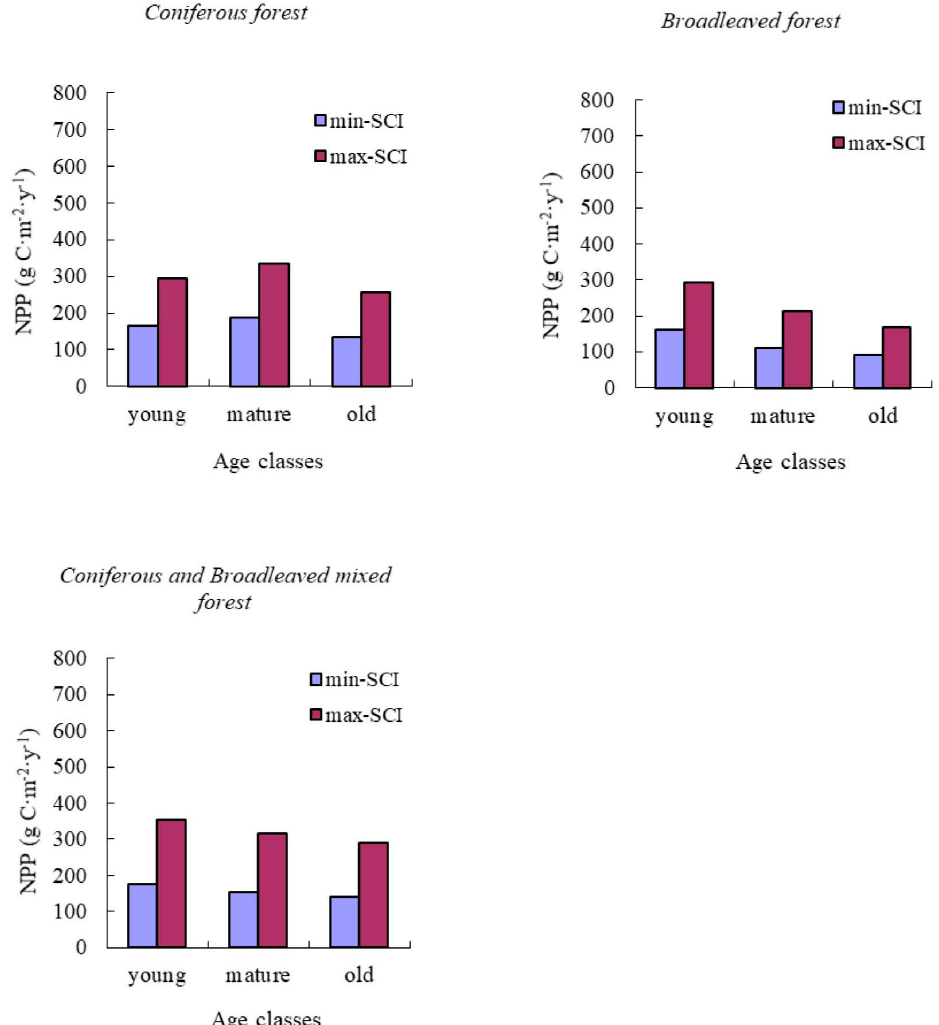
Figure 6. NPP for different age classes (young, mature, and old stands) in two categories of SCI values for the three forest type groups.